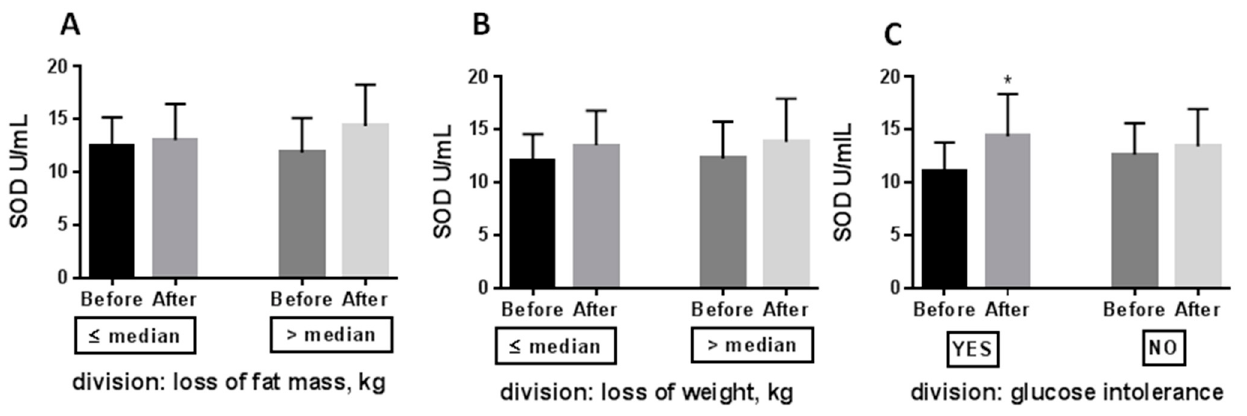
Figure 4. Effect of 8 weeks caloric restriction on serum superoxide dismutase (panel A – C ). Patients after caloric restriction were divided according to the median value regarding the fat mass loss, the bodyweight loss, and the glucose concentration after 2h of OGTT at baseline. The data were analysed using the paired/unpaired t -tests depending on Gaussian/ non-Gaussian distribution. Significance difference Before vs. After: * p < 0.05. Abbreviations: SOD—superoxide dismutase.